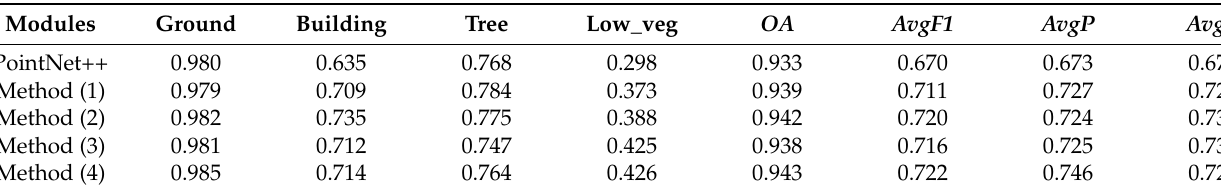
Table 8. Quantitative comparisons between our proposed method and PointNet++ network. The first five columns show the F 1 scores for each category. the boldface text indicates the best performance in each item.